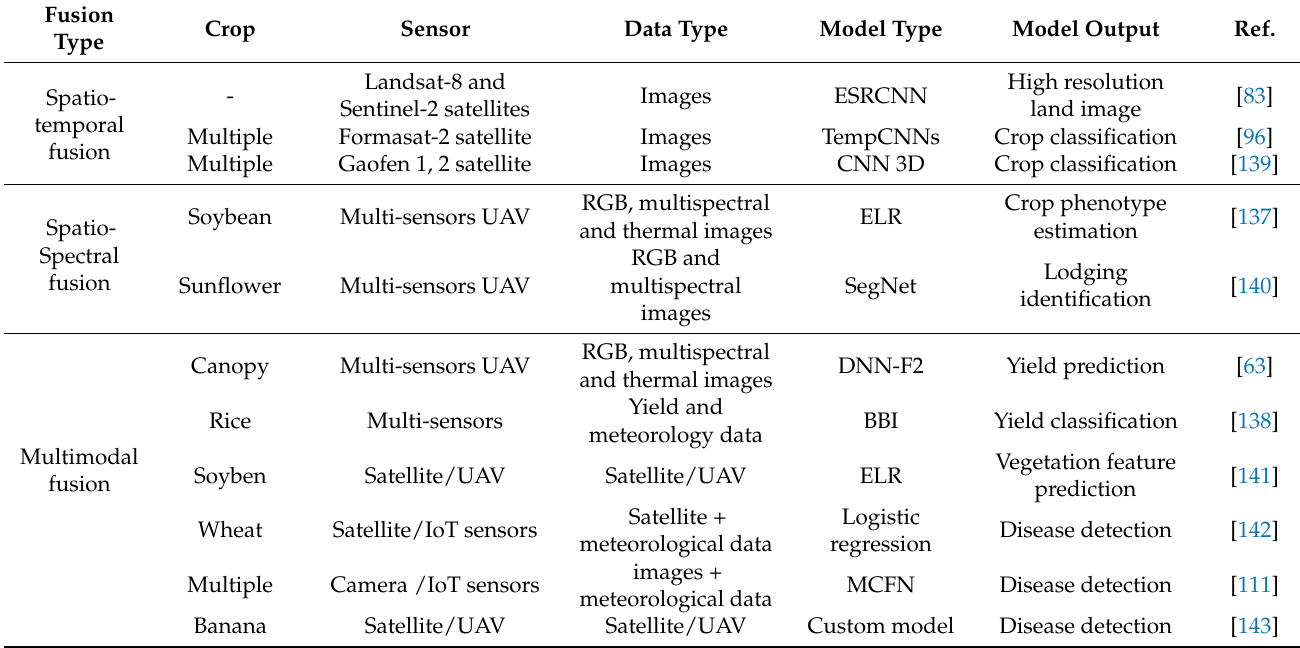
Table 6. Data fusion applications in